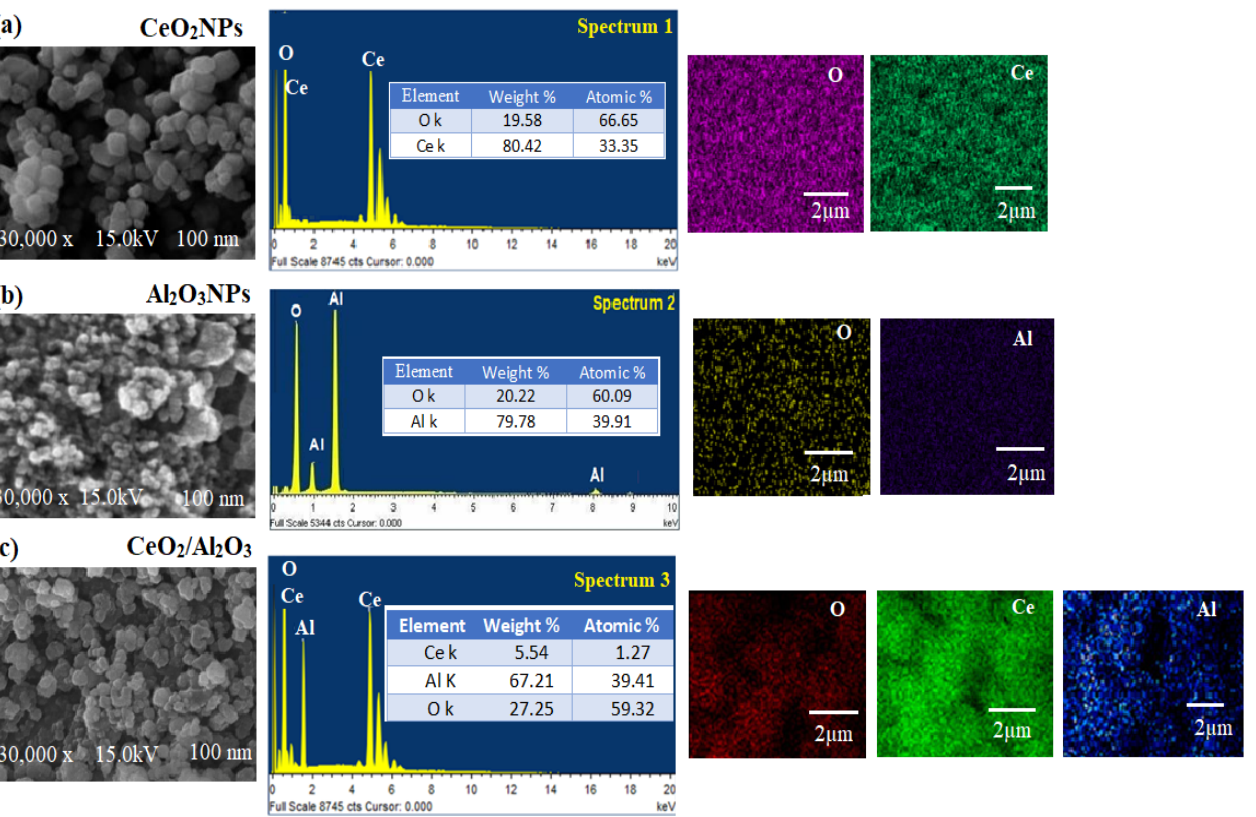
Figure 9. SEM, EDX and elemental mapping of ( a ) CeO 2 NPs, ( b ) Al 2 O 3 NPs, and ( c ) CeO 2 /Al 2 O 3 nanocomposite.